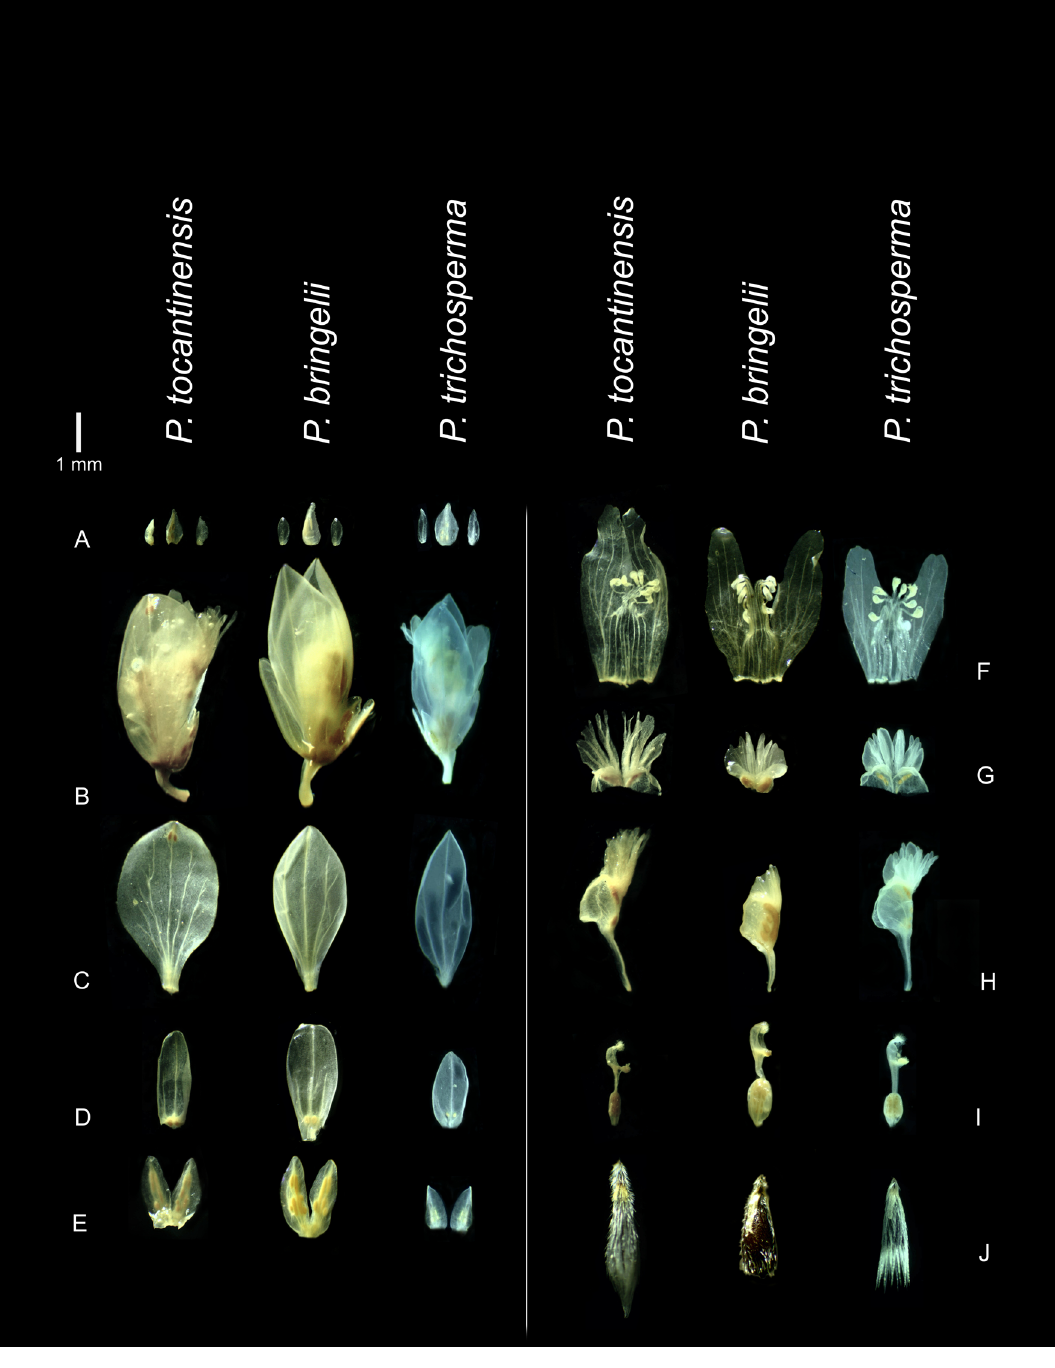
Fig. 8. Comparative plate of floral parts of P. bringelii J.F.B.Pastore & Antar sp. nov. ( G.M. Antar & L. Nascimento 380 ), P. tocantinensis J.F.B.Pastore & Antar sp. nov. ( J.M. Silva et al. 6769 ), and P. trichosperma Jacq. ( J.R. Abbott 19728 ). A . Bracts and bracteoles. B . Flowers. C . Inner sepals (wings). D . Lower outer sepal. E . Two upper outer sepals. F . Androecium and lateral petals. G . Crest. H . Keel. I . Gynoecium. J . Seed. Photos: J.F.B.